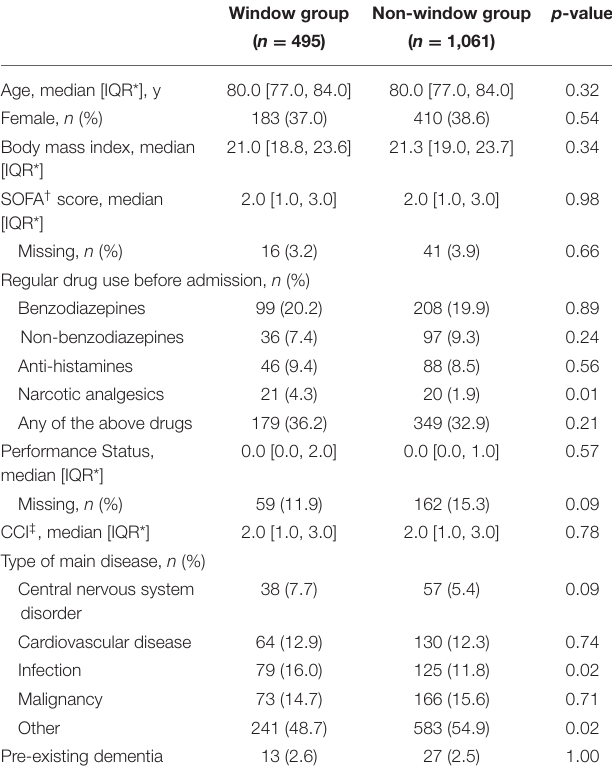
TABLE 1 | Baseline cohort